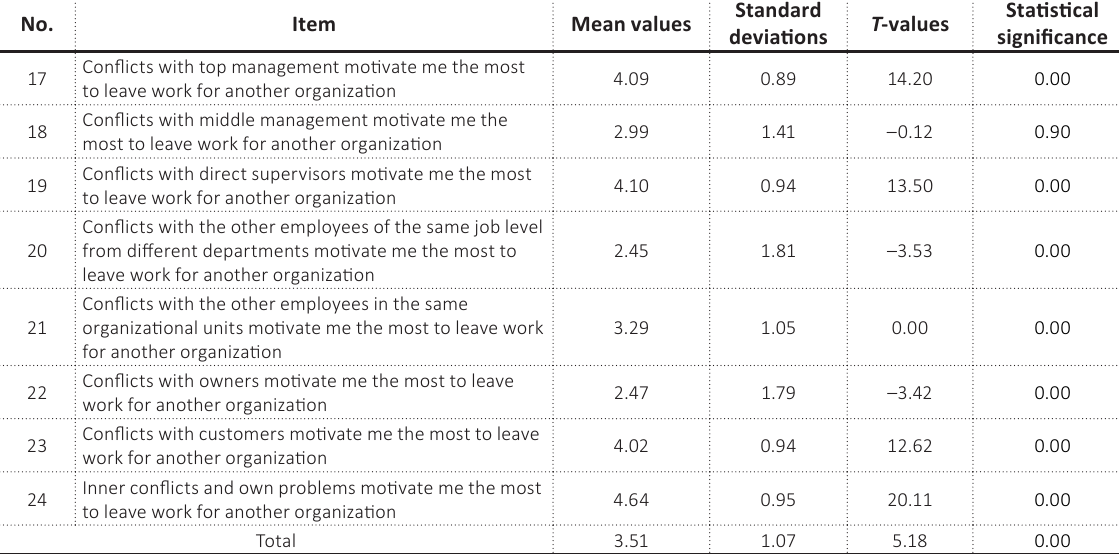
Table 6. Means, standard deviations, and T values for external turnover No.